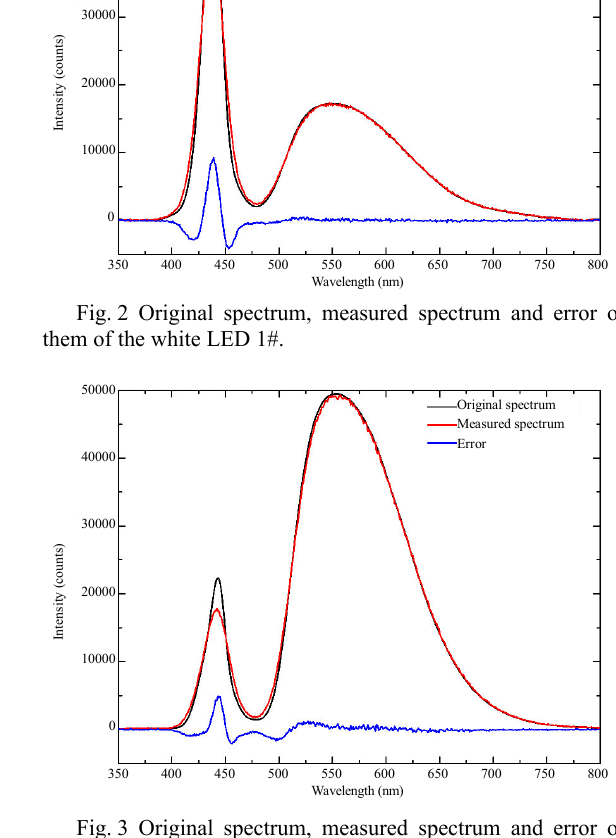
Fig. 3 Original spectrum, measured spectrum and error of them of the white LED